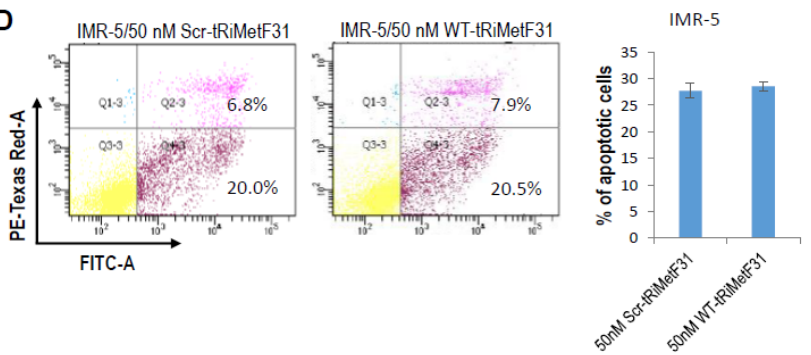
Figure 4. tRiMetF31 inhibits proliferation and induces G1 cell cycle arrest of IMR-5 cells. ( A ) IMR-5 cells were transfected with 12.5, 25, or 50 nM of either WT-tRiMetF31 or Scr-tRiMetF31. At 72 h after transfection, whole cellular lysates were prepared and subjected to Western blot analysis using antibody against PFKFB3, and GAPDH served as a loading control. Relative densitometry was measured using ImageJ, calculated as a ratio to GAPDH, and expressed as mean ± SD for three independent measurements. ( B ) IMR-5 cells were transfected with 25 or 50 nM of either WT-tRiMetF31 or Scr-tRiMetF31. At 24 h after transfection, cells were replated in 96-well plates, and MTT assay was performed as described in Section 4. ( C , D ) IMR-5 cells were transfected with 50 nM of either WT-tRiMetF31 or Scr-tRiMetF31. At 72 h after transfection, cells were harvested for cell cycle and apoptosis analyses as detailed in Section 4. *, p < 0.05; **, p < 0.01. Original western blot data is shown in Figure S3.